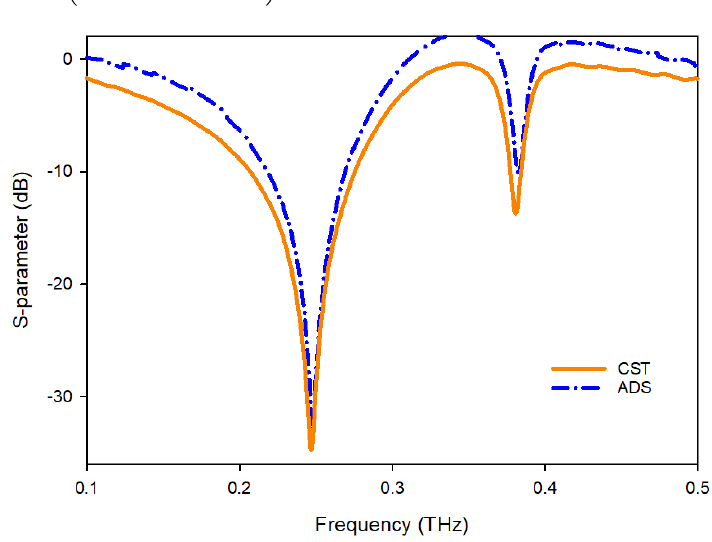
Figure 4. S21 comparison of the equivalent circuit result with simulation .